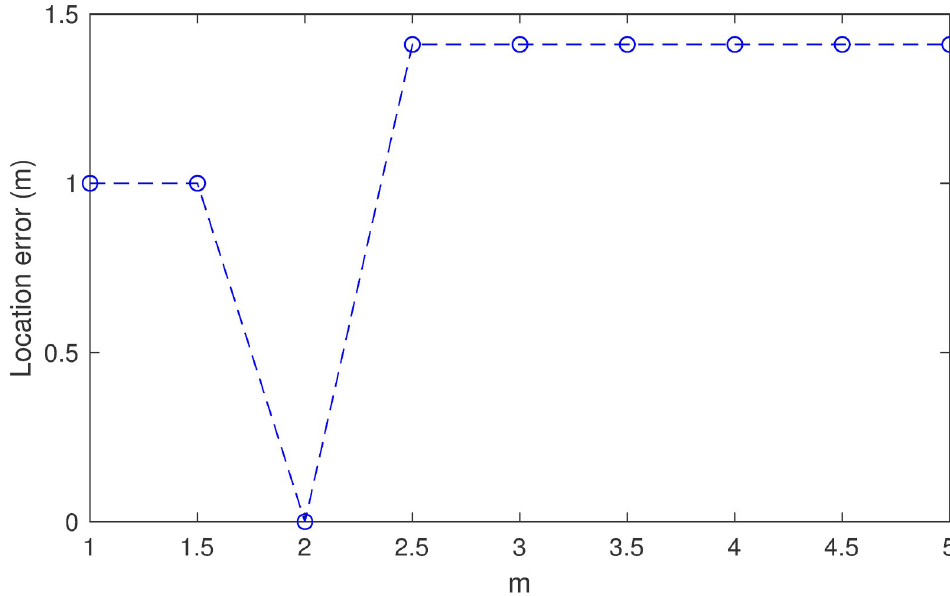
Fig 6. Location error versus the norm in example I.